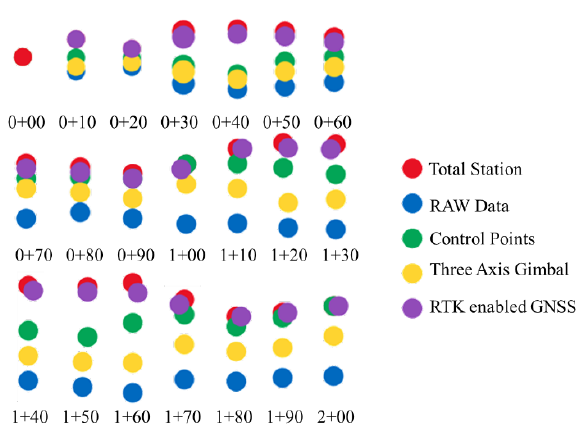
Figure 3. Relative positions of all methods by